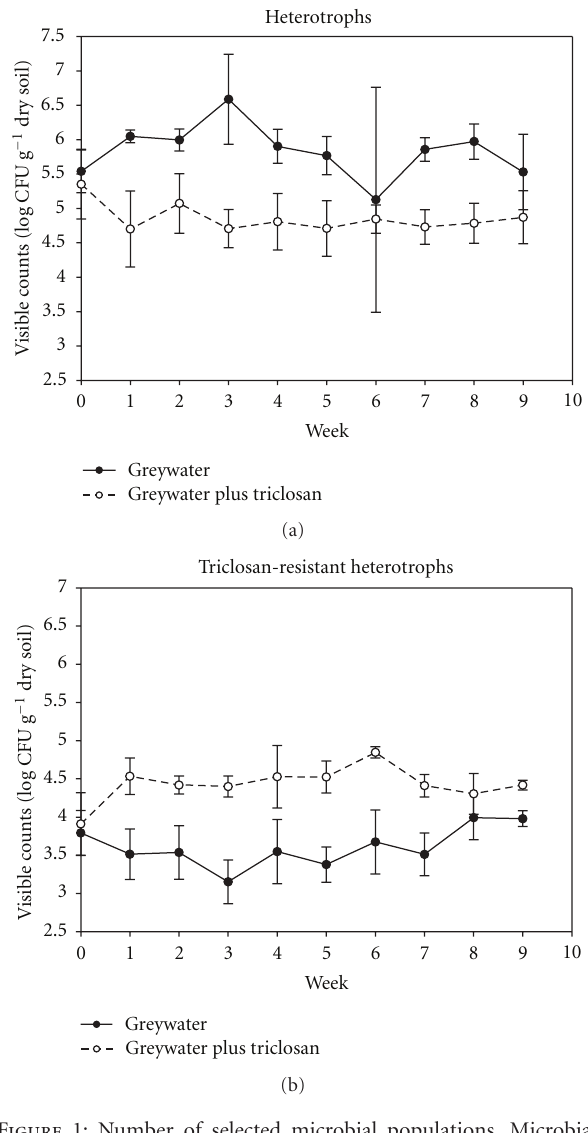
Figure 1: Number of selected microbial populations. Microbial numbers were determined as described in the methods. Data points are mean +/ − standard error of the mean (SEM). Note: mean and SEM were calculated using log transformed